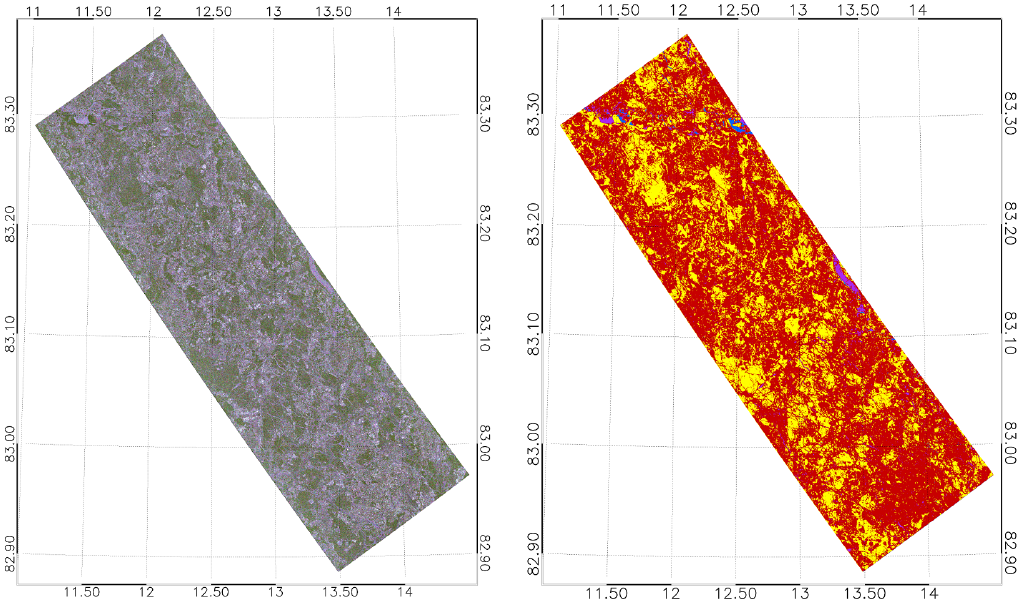
Figure A1. ( Left ) Geocoded Pauli RGB composite (Red: HH-VV Green: HV+VH Blue: HH+VV) of the TS-X acquisition on 19 April 2015, frame 1; ( Right ) ice classification. Blue: open water/nilas (OW), purple: young ice (YI), yellow: first year ice (SFYI), red: rough first year ice/multi-year ice